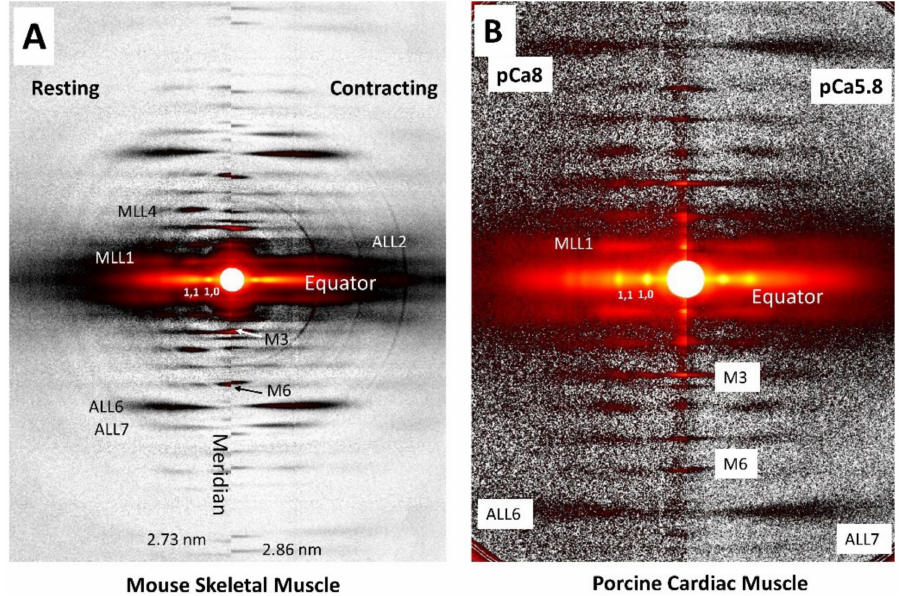
Figure 1. X-ray diffraction patterns. ( A ) X-ray diffraction patterns from intact mouse EDL muscle during resting (left panel) and contracting (right panel) conditions (based on reference [24]). ( B ) X-ray diffraction patterns from permeabilized porcine cardiac tissue at pCa8 (left panel) and pCa5.8 (right panel) (based on reference [49]). Panels A and B are on approximately the same intensity scale. The signal to noise is much better in the patterns shown in panel A since they are from whole intact skeletal muscle and the patterns shown in panel B are from a small cardiac fiber bundle.